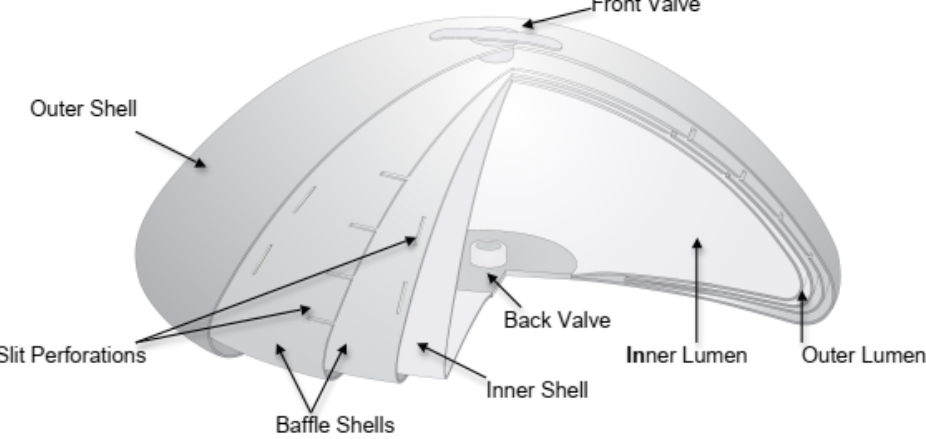
Figure 1. Cut-away Drawing of the IDEAL IMPLANT.